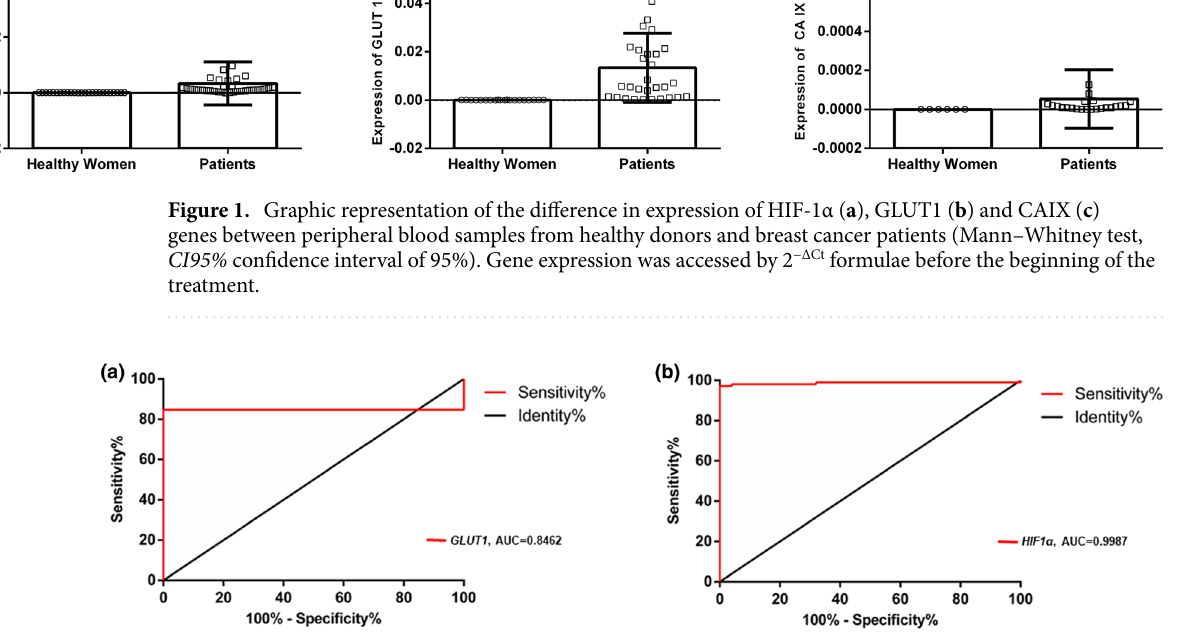
2 −ΔCq > 0.00017, sensitivity of 84.62% (95% CI 76.78–90.62%) and specificity of 92.31% (95% CI 74.87–99.05%).